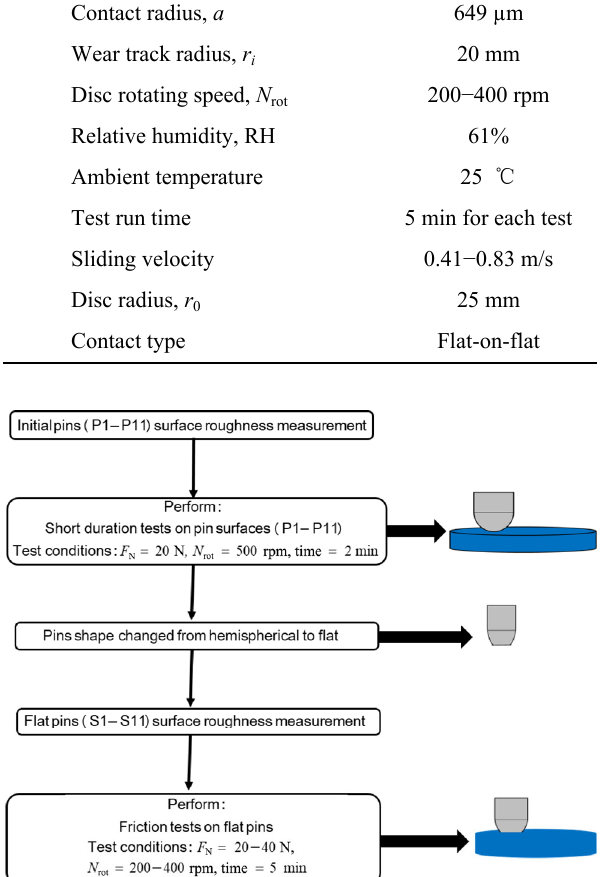
Fig. 4 Surface map of unworn disc (AISI 52100